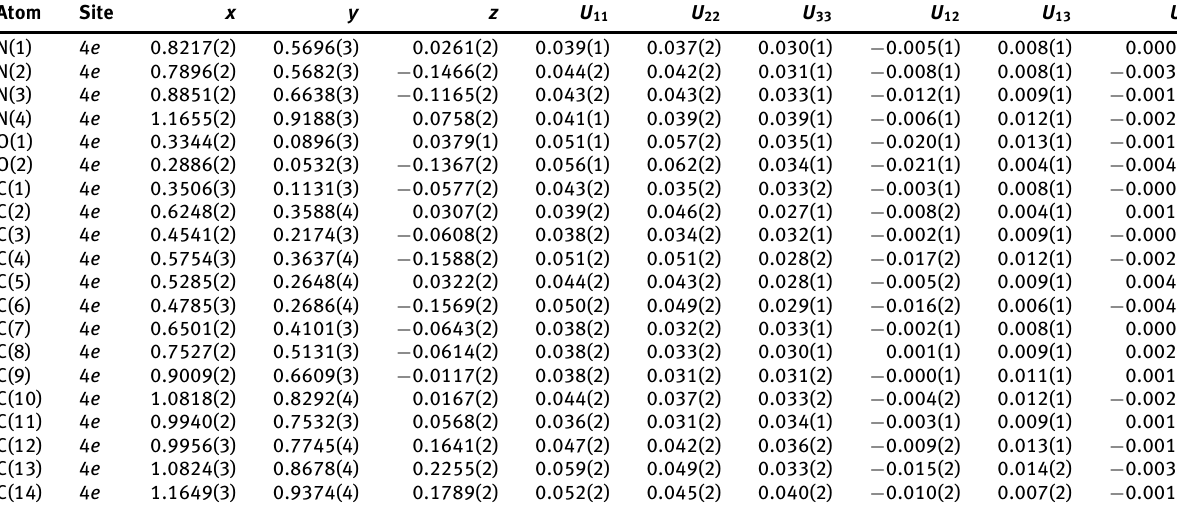
Table 3: Atomic displacement parameters (Å 2